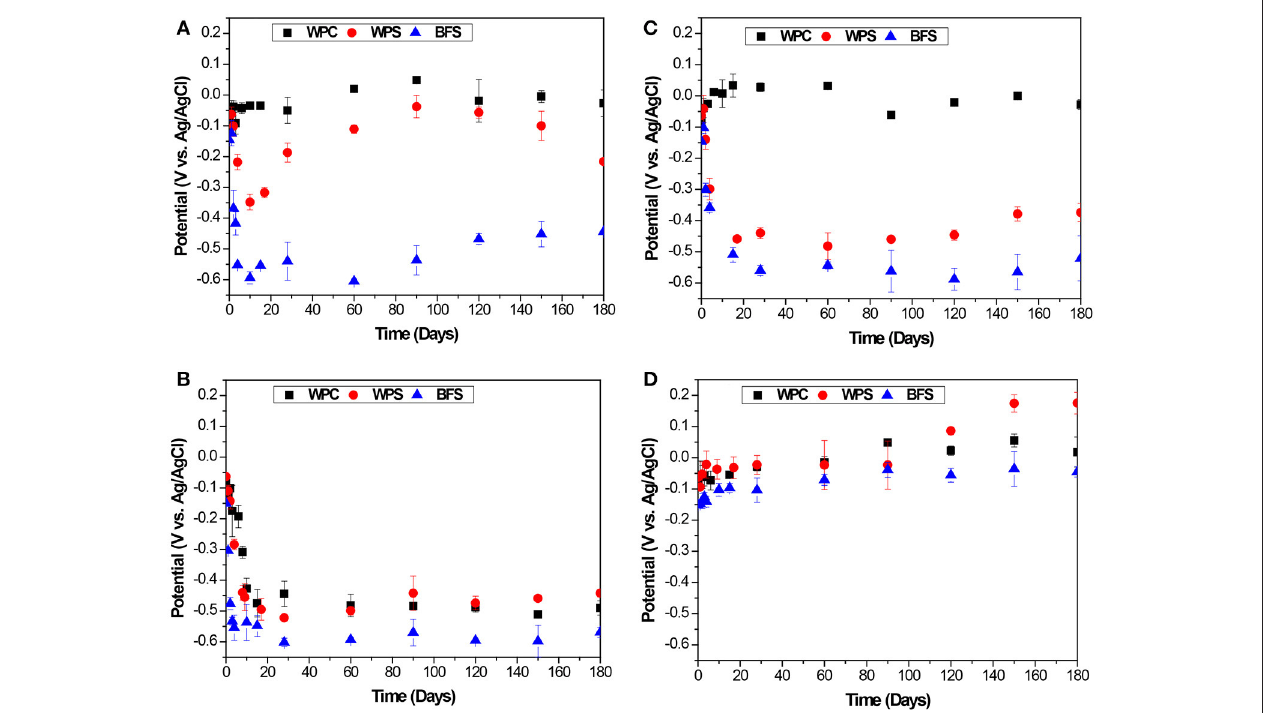
FIGURE 2 | Evolution of the potential values as a function of time, for steel embedded in BFS, WPS, and WPC mortars immersed in (A) alkaline solution, (B) alkaline chloride-rich solution, (C) water, and exposed to (D) standard laboratory conditions, with 7 days of curing prior to immersion or exposure.